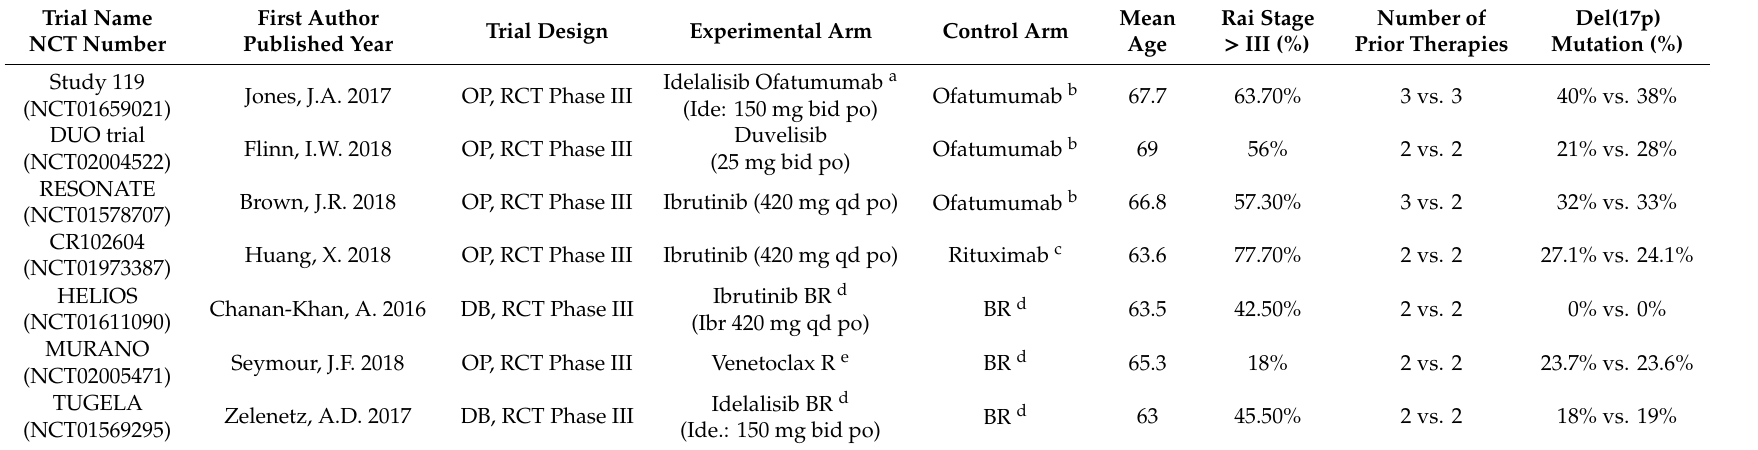
Table 1. Trial details and patient